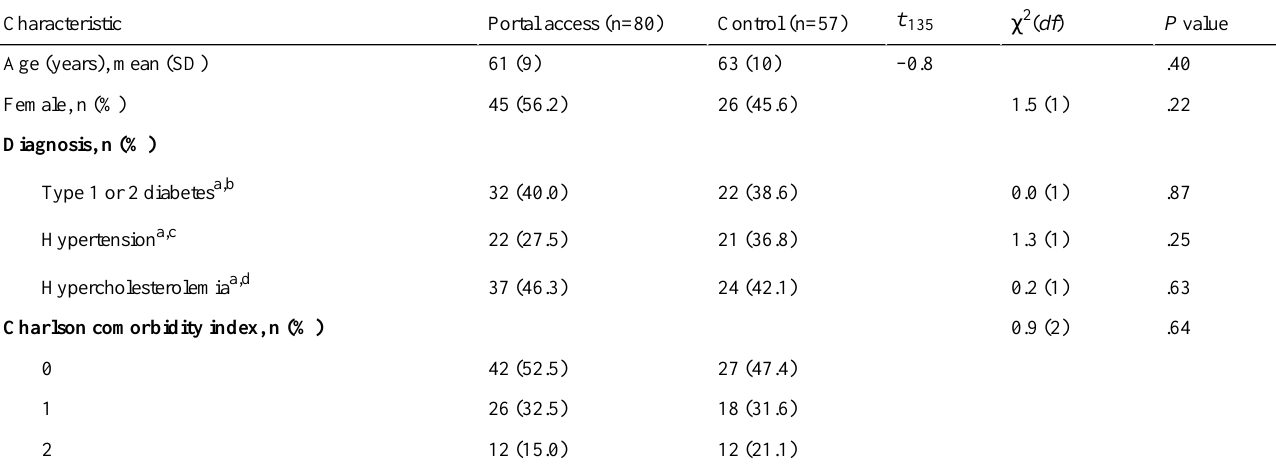
Table 1. Baseline characteristics of study participants